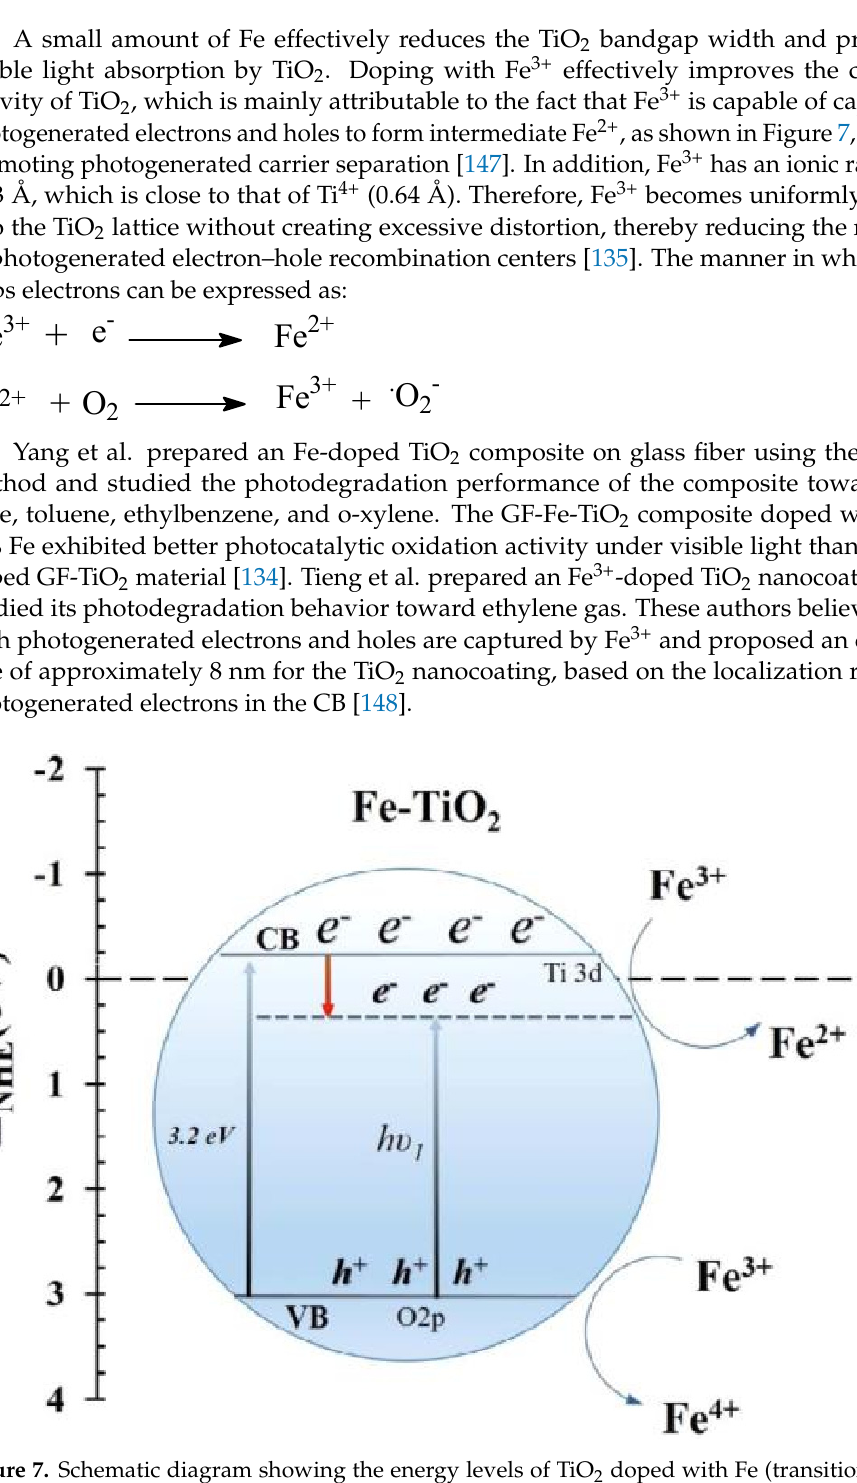
Figure 6. Postulated mechanism for electron transfer in NiO/TiO 2 nanoparticles [145]. Reprinted/adapted with permission from Ref. [131]. 2021, ACS Publications.